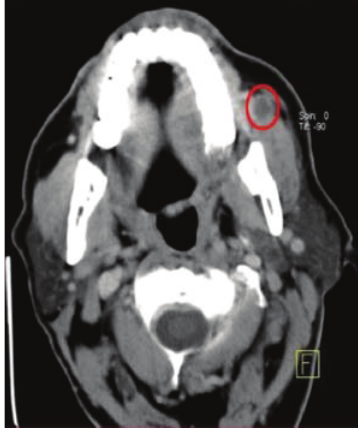
Figure 1: Head CT image showing a malignant lesion in the left buccal